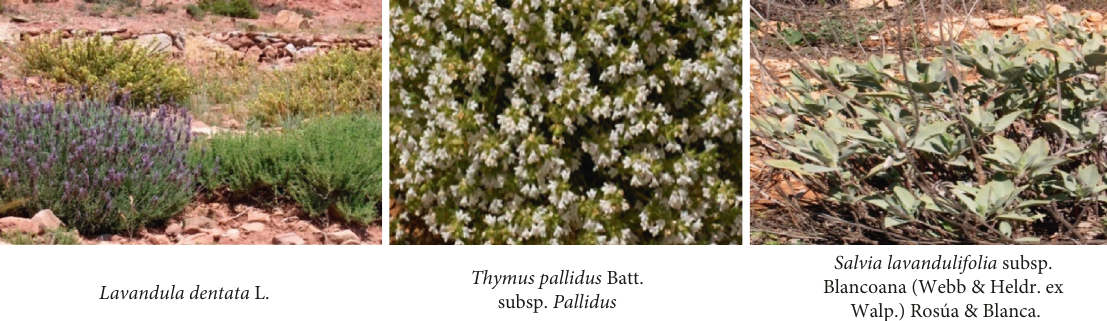
Figure 9: Biomass estimate for three species of the Bigoudine watershed.